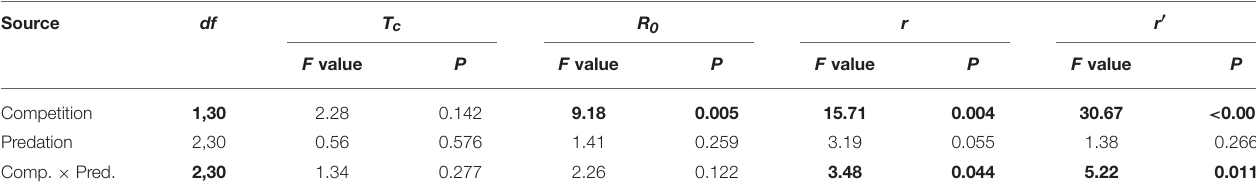
TABLE 7 | ANOVA results for life table traits of Aedes aegypti such as cohort generation time ( T c ), net reproductive rate ( R 0 ), cohort rate of increase ( r ) and index of population performance ( r’ ). Source df